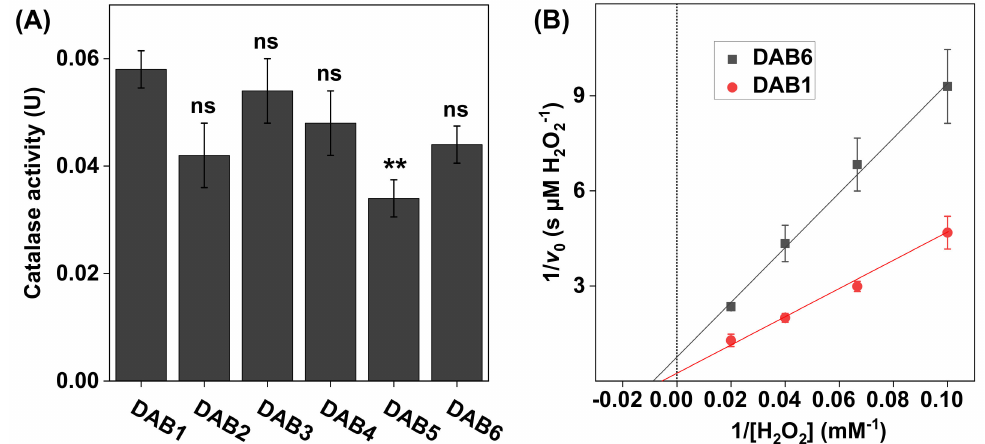
Figure 5. ( A ) Catalase activity in DAB samples harvested at different time points between 2016 (DAB1) and 2018 (DAB6). All experiments were performed in triplicates ( n = 3, mean ± SD) with 10 mM H 2 O 2 at pH 7.5 and 1.0 mg of DAB sample in 5 mL of PBS. ( B ) Lineweaver–Burk plots for DAB1 and DAB6 obtained with 10, 15, 25, and 50 mM of H 2 O 2 , where linear extrapolations were used to determine the Michaelis constant K M and maximal reaction velocity v max according to Equation (6). The correlation coefficients were r 2 = 0.993 for DAB1 and r 2 = 0.996 for DAB6. ** p < 0.01 and ns = p >